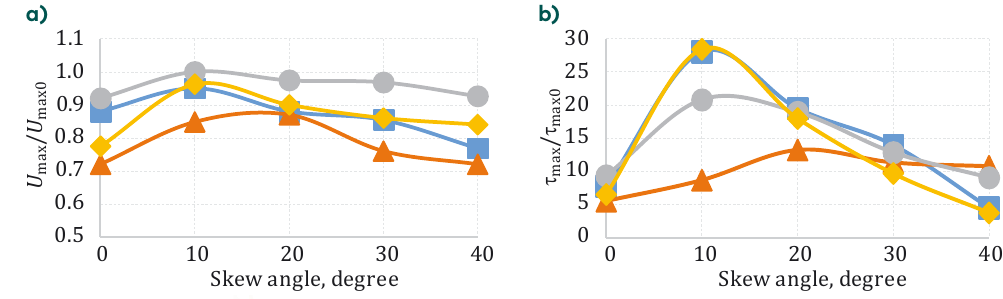
Figure 14. Diagram of velocity and shear stress changes for different cases: a) maximum velocity diagram around the flow-guiding embankment; b) maximum shear stress diagram around the flow-guiding